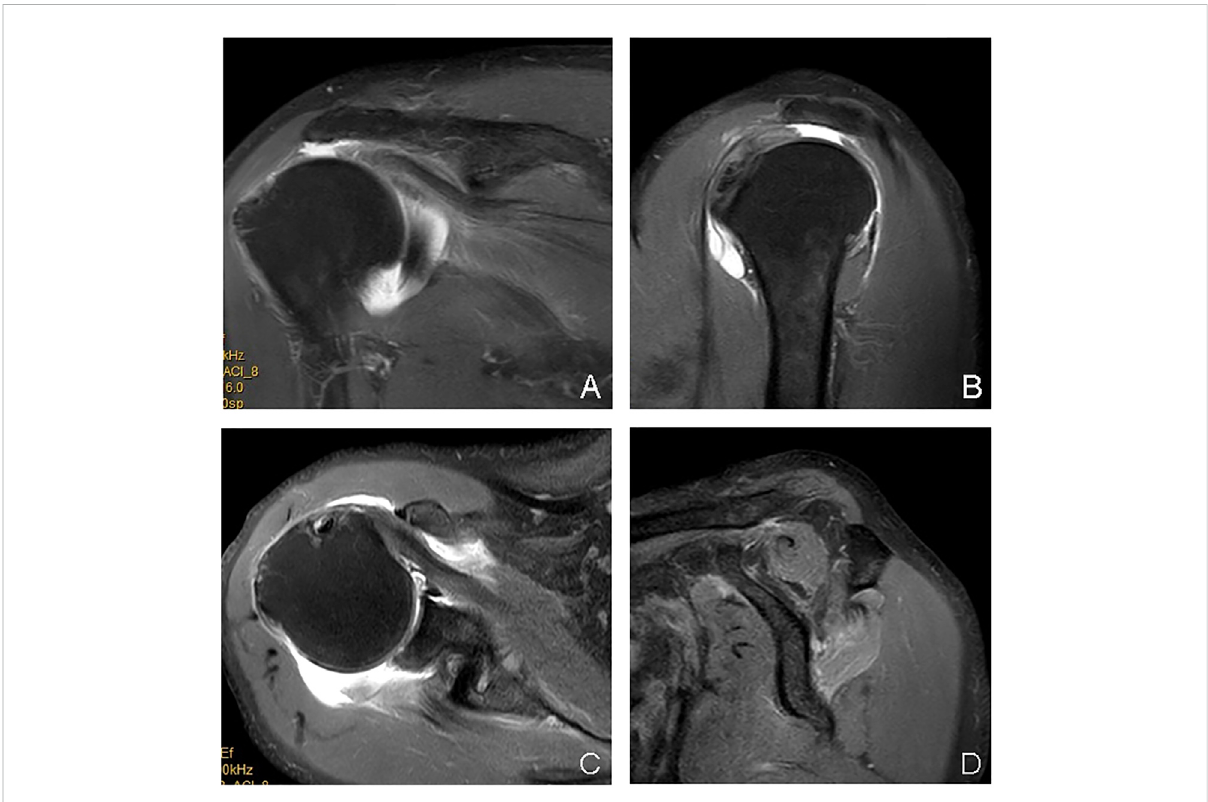
FIGURE 4 A typical case of the complete tear group: male, 70 years old, right shoulder joint, a complete tear of the supraspinatus and infraspinatus in the tubercle insertion area, the stump tendon had retracted (A – C) ; supraspinatus and infraspinatus muscle atrophy with intramuscular fat